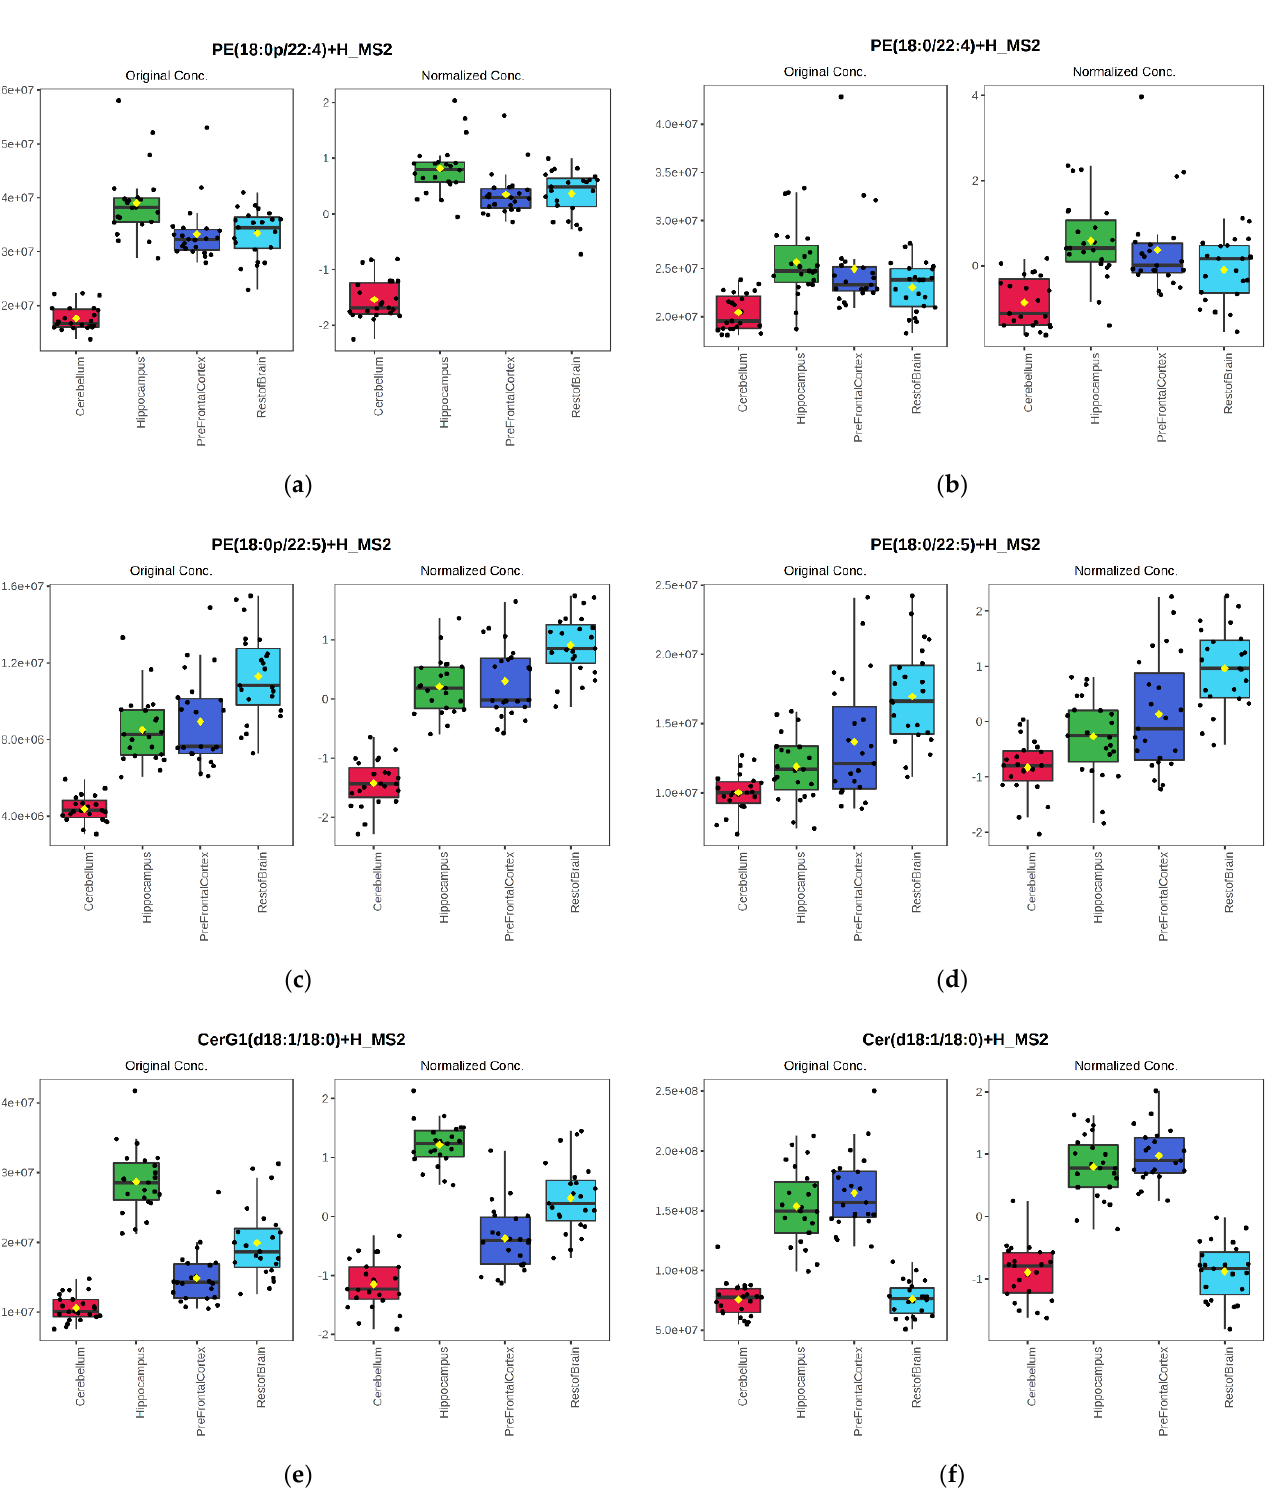
Figure 4. Peak area bar charts and log10 transformed and auto-scaled peak area boxplots of six lipid species detected across the four brain regions (cerebellum, hippocampus, prefrontal cortex, and the rest of the brain) in positive mode, regardless of intervention (n = 23 animals). Lipid IDs for ( a – f ) are given in the boxplot figure legends. All six lipid species shown were significantly different across brain regions (FDR corrected p < 0.05) by ANOVA.